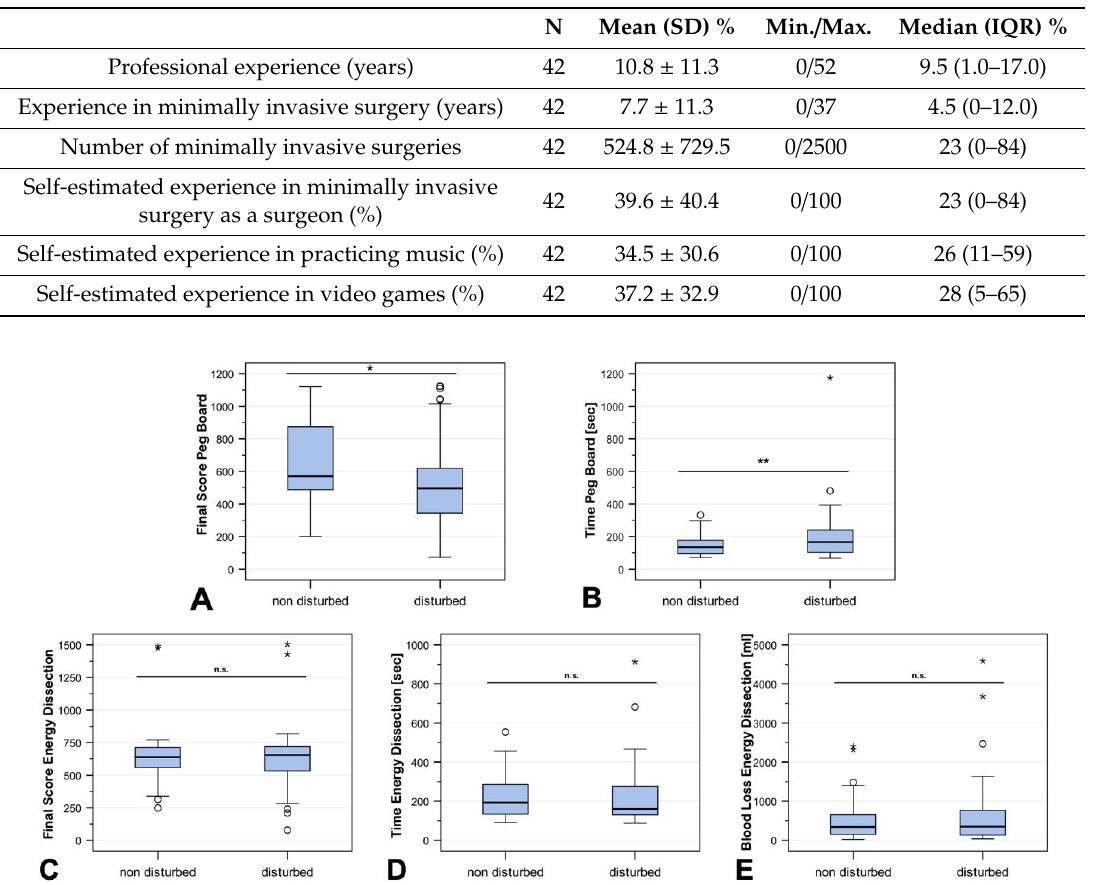
Figure 4. Comparison of the final score (FSC) and the time to complete the exercise (TTCE) for Peg Board ( A ) and ( B ) and Energy Dissection ( C ) and ( D ) with and without disturbance. ( E ) Blood loss